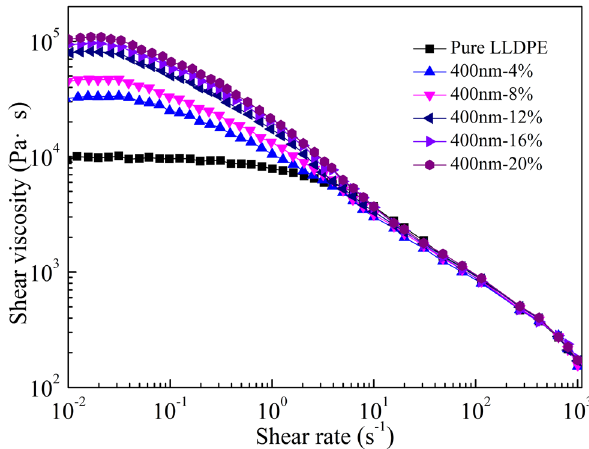
Figure 2: Shear viscosity versus shear rate of the nano Al 2 O 3 /LLDPE composites with di ff erent Al 2 O 3